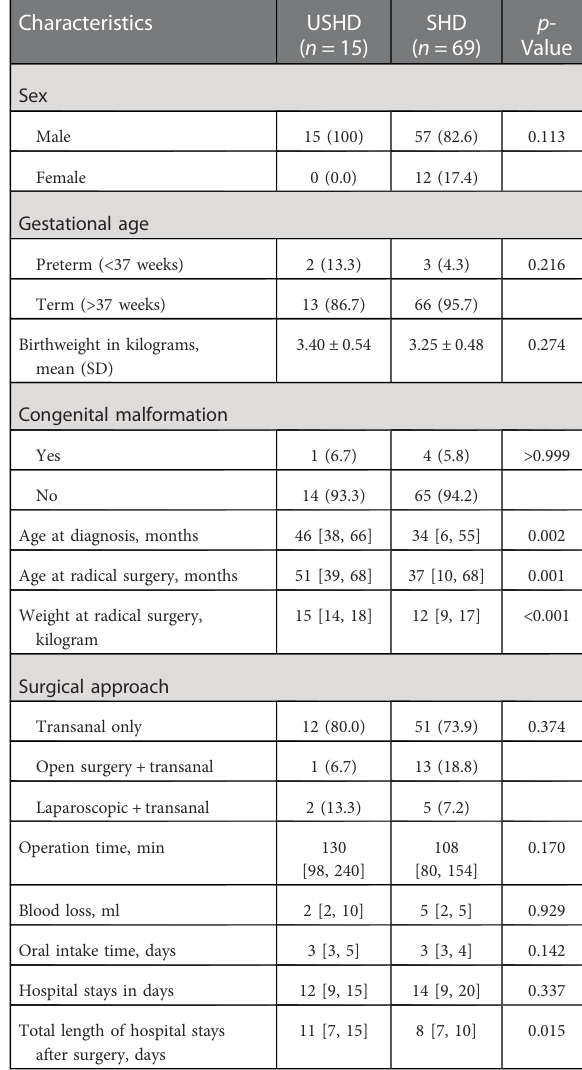
TABLE 4 Bowel function score (>4 years